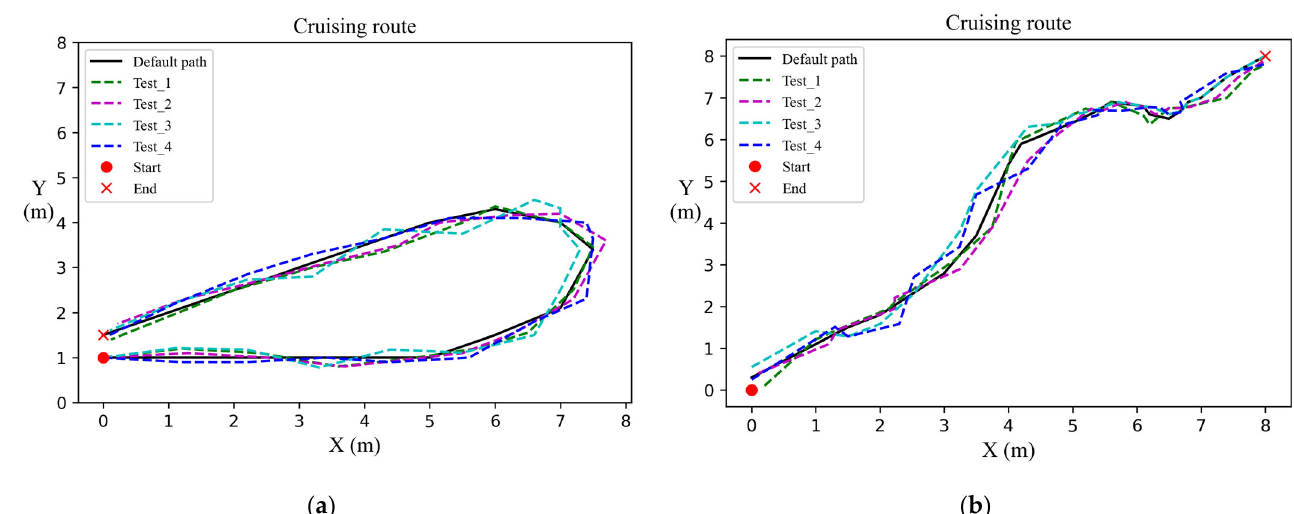
Figure 13. T Four test routes and preset routes, listed as: ( a ) path 1; ( b ) path 2.